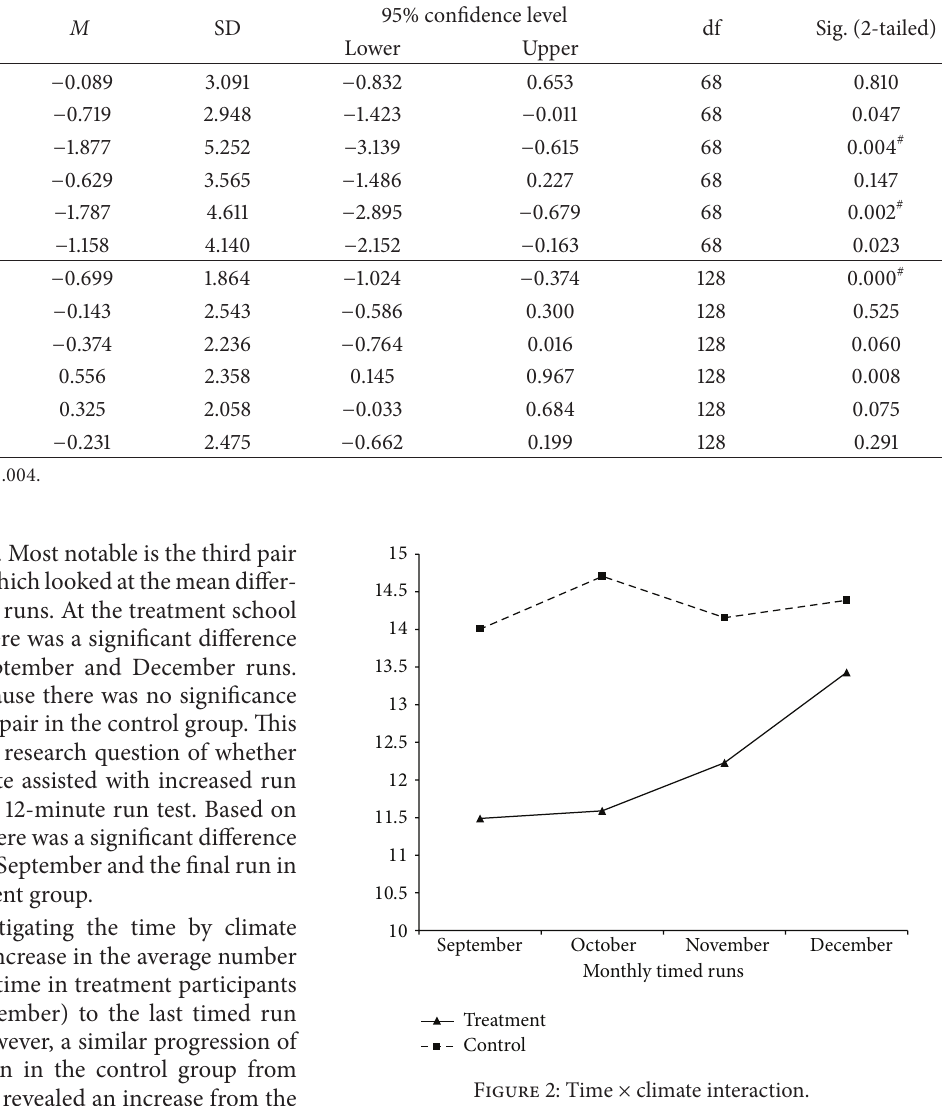
Table 3: Paired monthly runs.